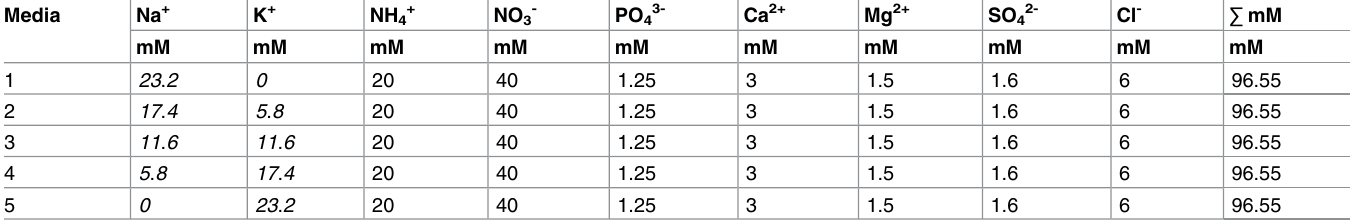
Table 3. The five unique formulations that comprised the experiment. The experimentwas free of ion confounding because only the target ions Na + and K+ were varied. All other ions in MS medium were held constant. Media